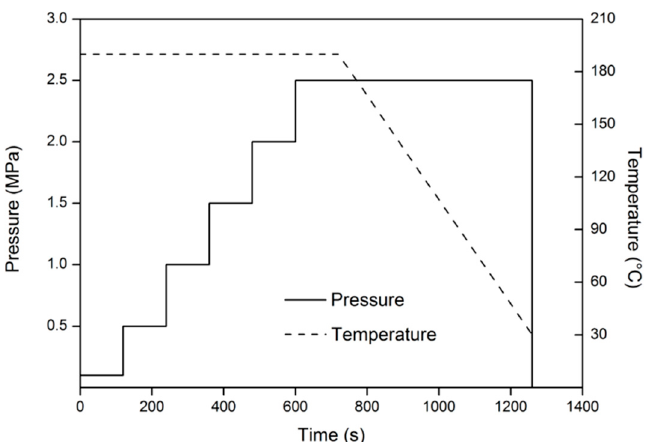
Figure 2. Processing conditions used to manufacture polypropylene (PP)- and polypropylene modified with a coupling agent (PPc)- based